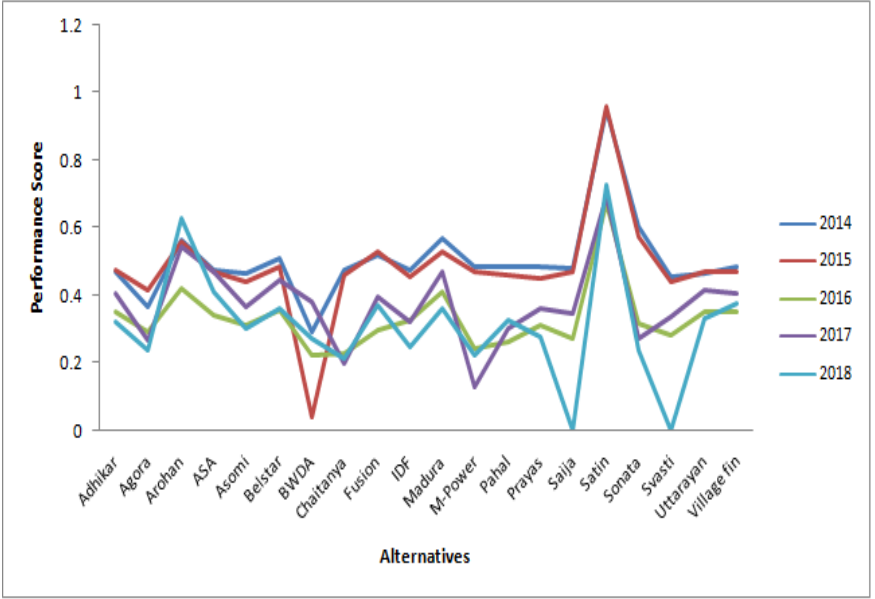
Figure 1. Variation in performance score.